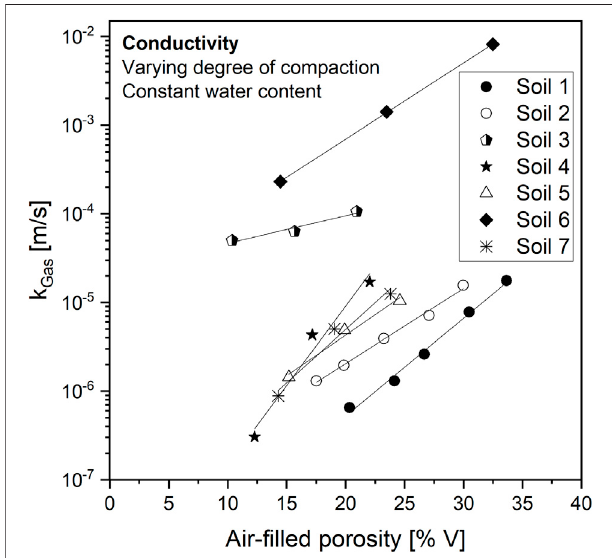
FIGURE 5 | Gas permeability function ( fl uid = air) with air- fi lled porosity ( ε a ) adjusted by degree of soil compaction in different sandy candidate MOL soils. Note logarithmic scale on y -axis. From Gebert et al. (2019).